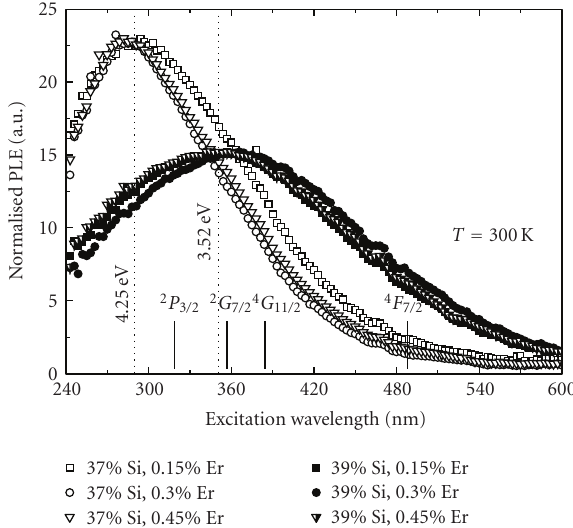
Figure 2: Normalized PLE spectra of Er 3+ codoped Si x O y films with di ff erent at. % of Si and Er measured at 1534